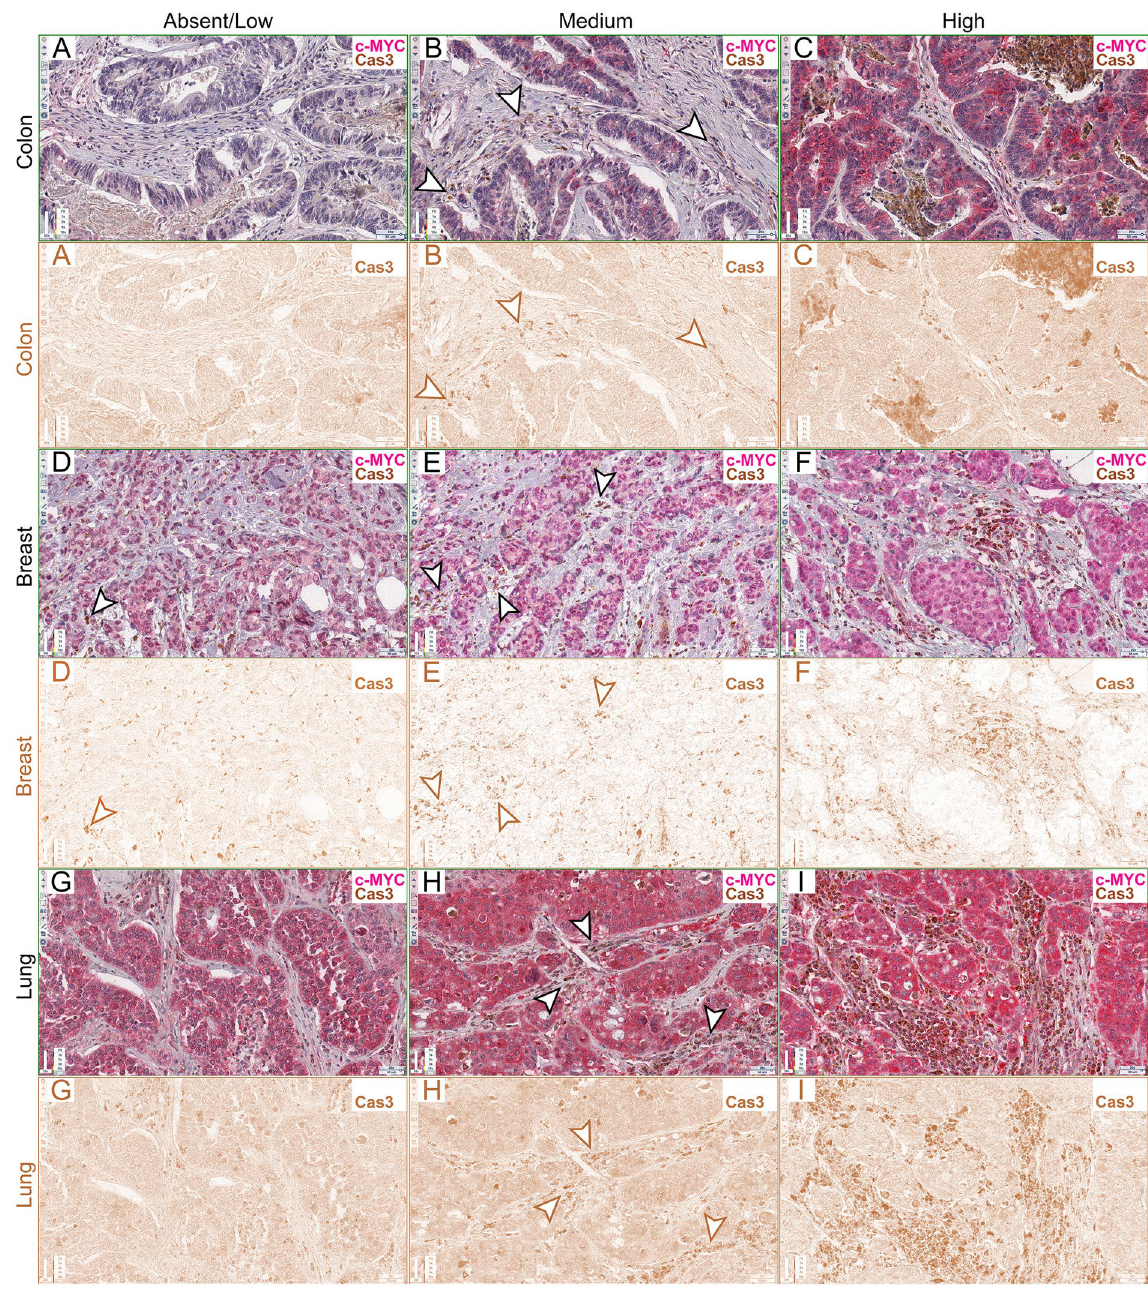
Figure 4. Caspase 3 quantification in human cancer samples. ( A – I ) c-MYC and Cas3 staining of colon ( A – C ), breast ( D – F ) and lung ( G – I ) human cancer samples. For each sample, the original RGB image (upper panels) and the deconvolved DAB image (lower panels) are shown. The arrowheads in ( B , D , E and H ) highlight stromal cells positive to Cas3 staining. In ( C , F and I ) cell death is self-evident. Scale bars are indicated in each